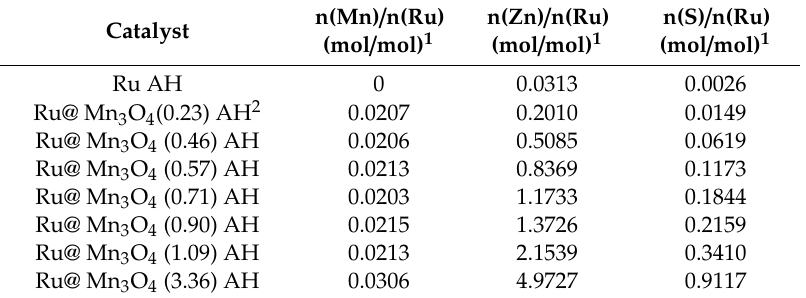
Table 2. Composition of monometallic Ru as well as Ru@Mn 3 O 4 ( x ) after catalytic experiments.